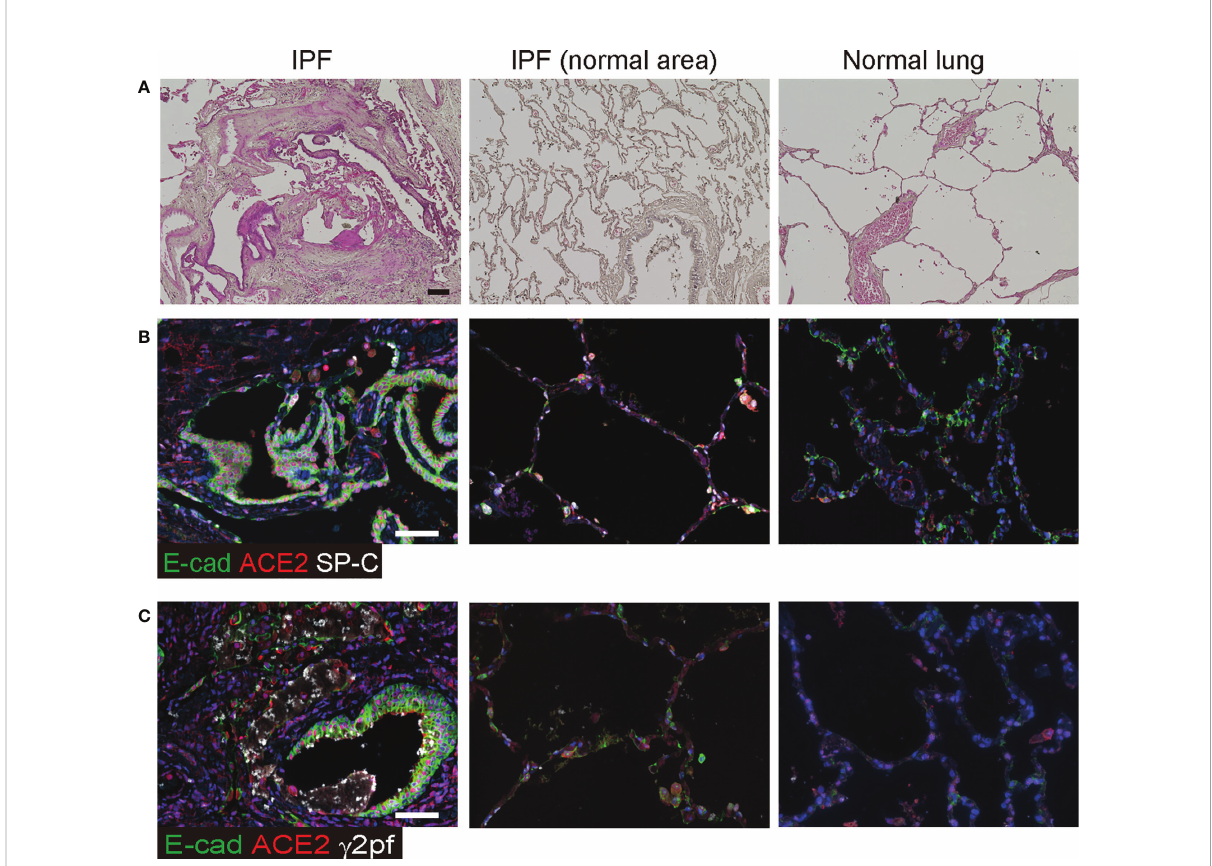
FIGURE 3 ACE2 was detected in epithelial cells of patients with IPF. (A) Histopathology of human normal lung and IPF lung. Specimens were stained with hematoxylin and eosin. (B) Immunohistochemical staining for E-cadherin (green), ACE2 (red), and SP-C (white) in the honeycombing region and normal area of IPF lung or the control. (C) Immunohistochemical staining for E-cadherin (green), ACE2 (red), and g 2PF (white) in squamous hyperplasia and the control area. Scale bars indicate 50 µm (black or